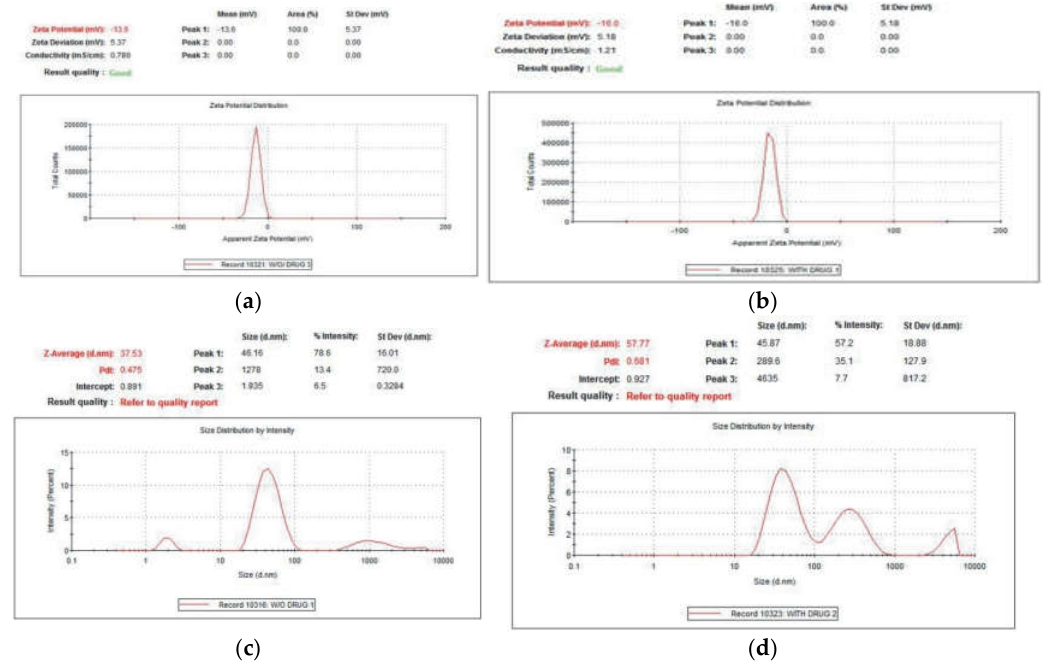
Figure 5. ( a ) Zeta potential of AuNPs functionalized with crude flavonoids extract of M. biflora ; ( b ) Zeta potential of Au-amoxi conjugate . ( c ) Size distribution of AuNPs. ( d ) Size distribution of Au- ( b ) Zeta potential of Au-amoxi conjugate. ( c ) Size distribution of AuNPs. ( d ) Size distribution of amoxi conjugate. Au-amoxi conjugate.